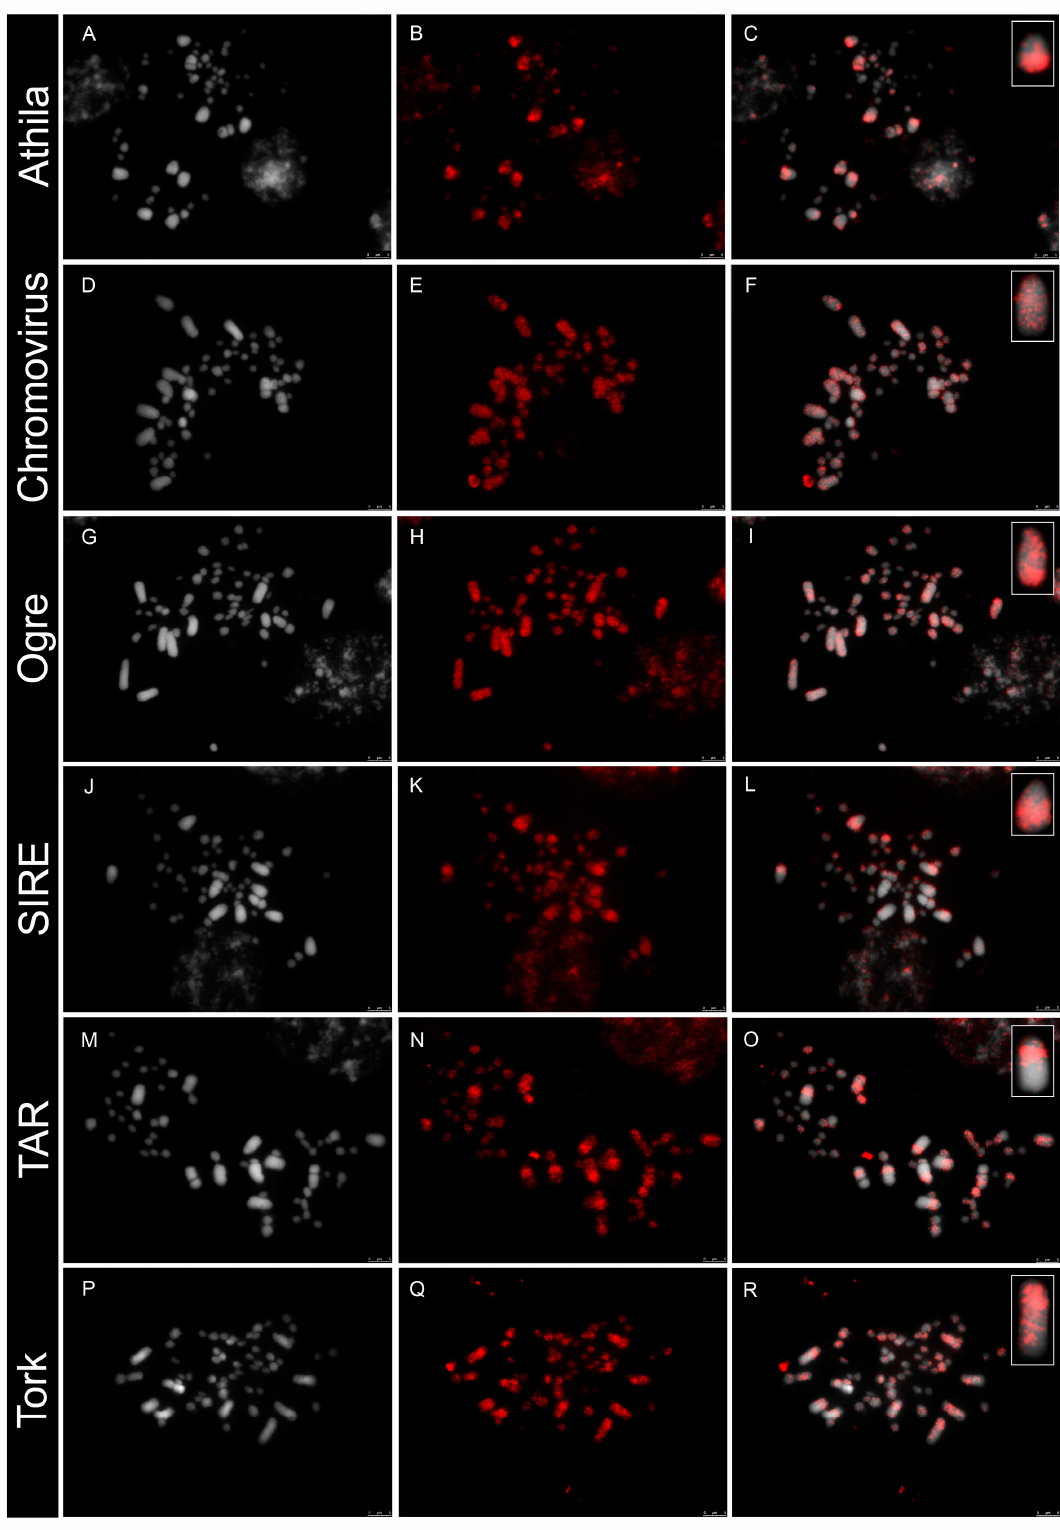
Figure 1. Distribution of the most abundant LTR retrotransposons (in red) in the mitotic chromosomes of hybrid Agave 11648 (DAPI in grey) after FISH, showing the differential chromosome patterns and accumulation at the macrochromosome pairs. ( A – C ), Ty3/gypsy Athila; ( D – F ), Ty3/gypsy Chro- movirus; ( G – I ), Ty3/gypsy Ogre; ( J – L ), Ty1/copia SIRE; ( M – O ), Ty1/copia TAR; ( P – R ), Ty1/copia Tork. Insets show one macrochromosome of the same cell at higher